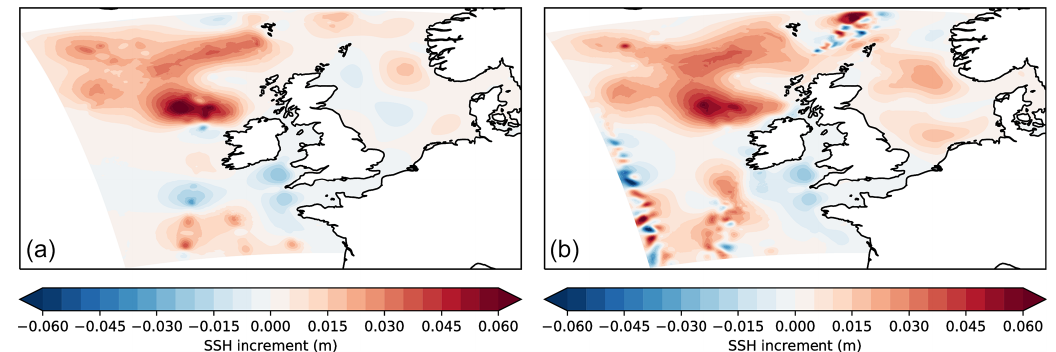
Figure 9. SSH increments for an example day (31 October 2017) from the control (a) and LowErrSWOT experiments (b)